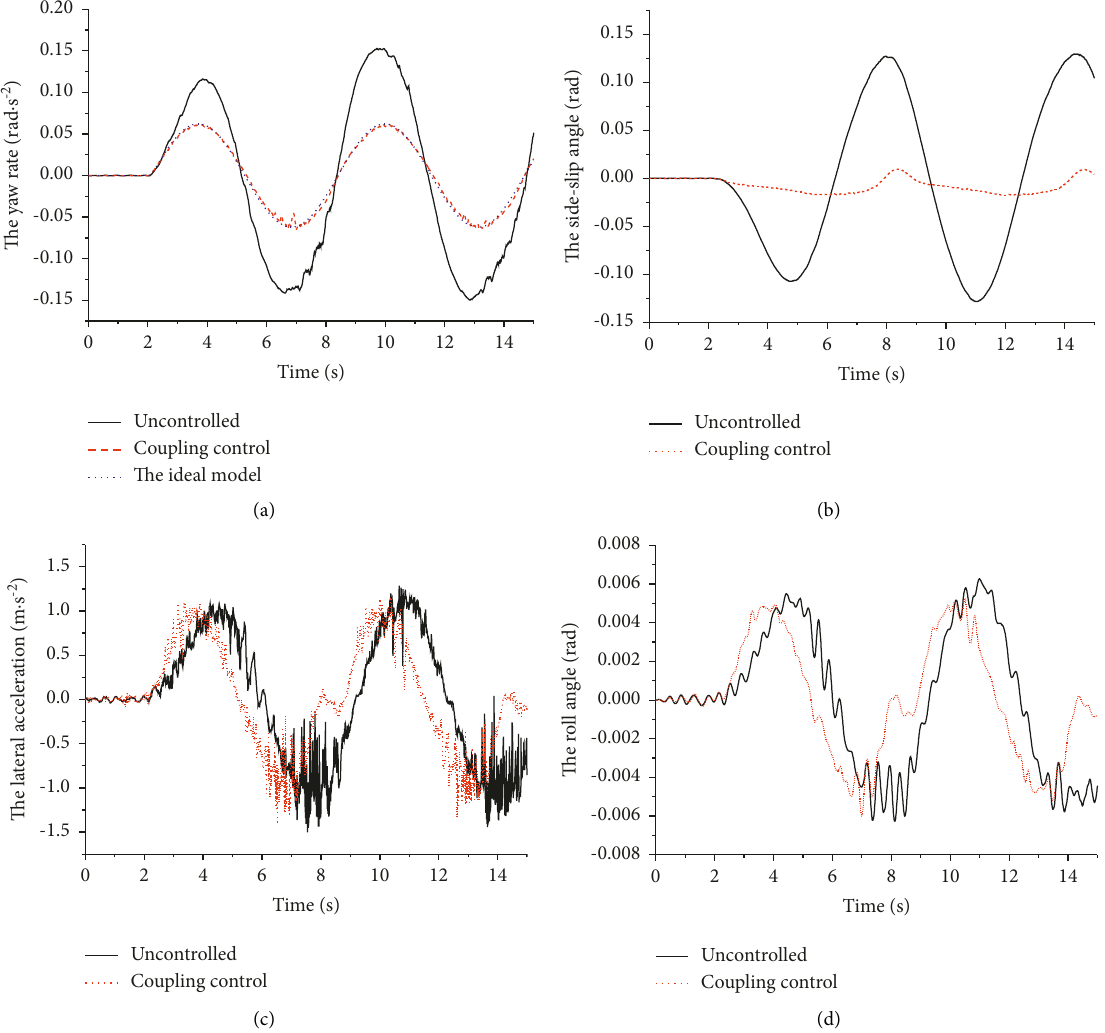
Figure 14: Handling stability control result under serpentine condition. (a) Yaw rate. (b) Side-slip angle. (c) Lateral acceleration. (d) Roll